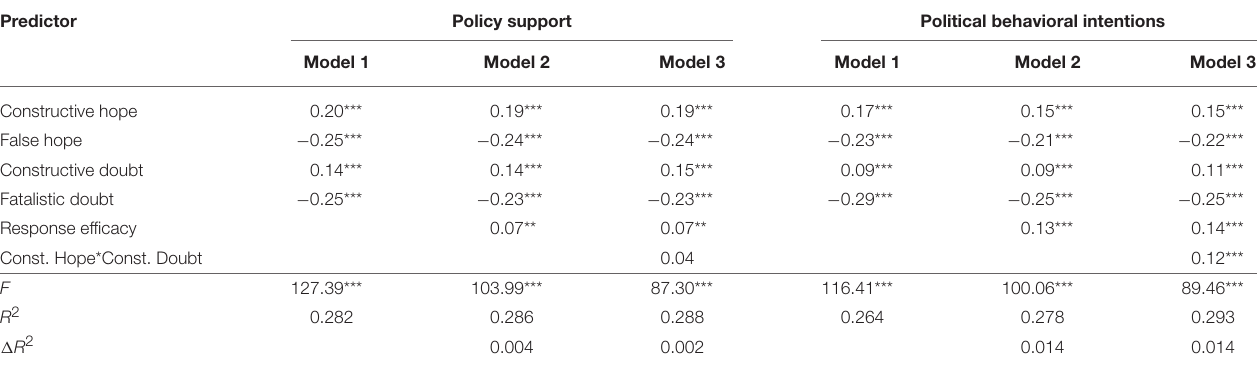
TABLE 5 | Hope and doubt predicting policy support and political behavioral intentions ( N = 1,310).